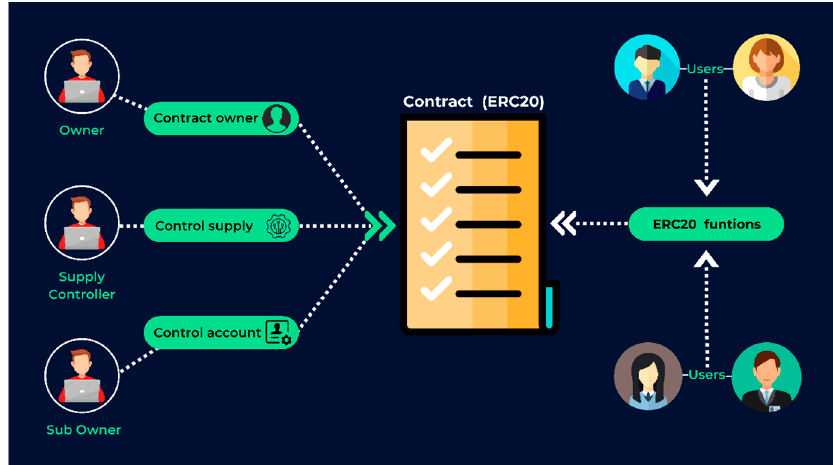
Figure 4. Contract ERC-20 Interface .